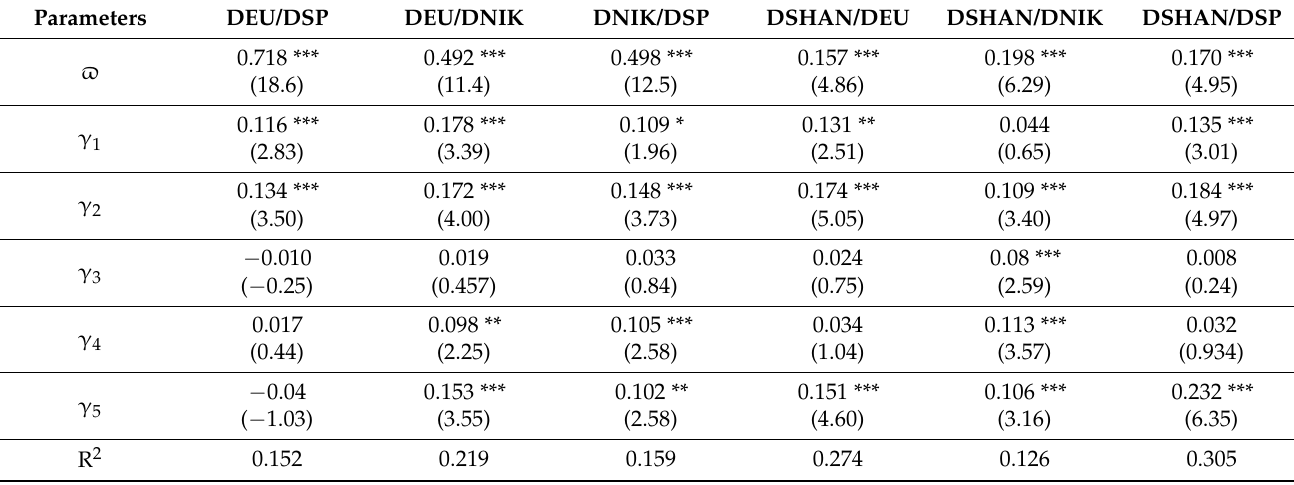
Table 4. Impact of Financial Crises on Dynamic Conditional Correlations between Stock Returns. Sample 2000M11–2019M3 (221